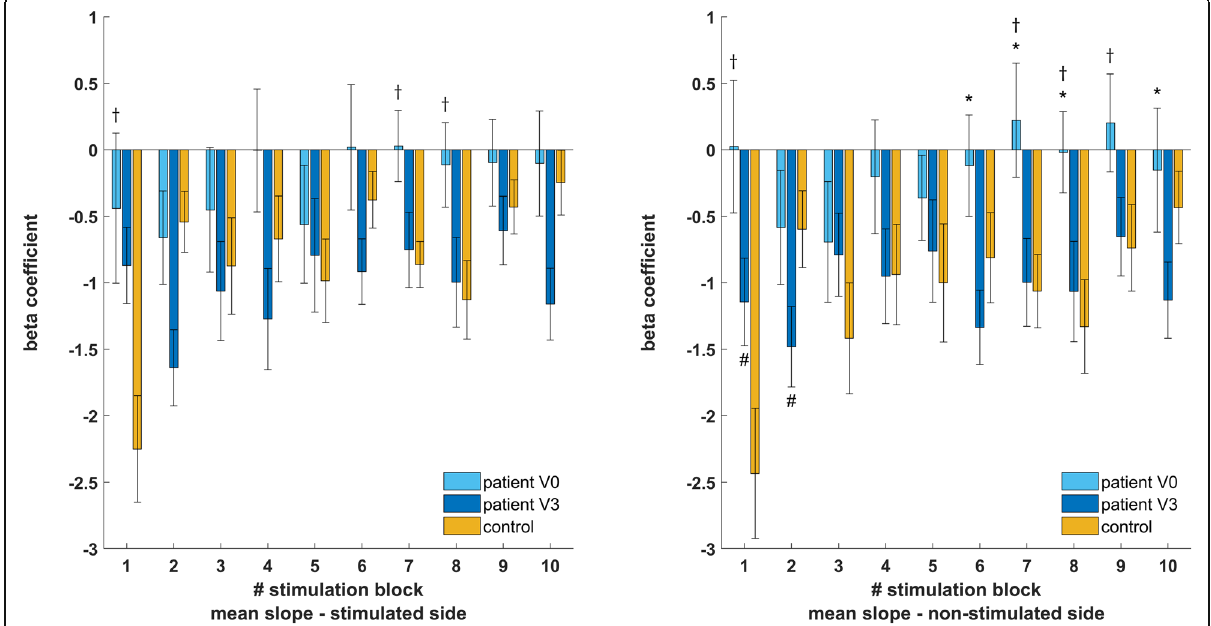
Fig. 3 blockwise comparison of nBR habituation in patients with migraine and controls. R2h is attenuated in migraine and has even a trend towards facilitation in later blocks at V0. After three months of treatment with CGRP mAbs, R2h normalizes and consecutive stimuli are inhibited in all blocks. There remains a significant difference between V3 and controls on the non-stimulated side. * - indicates statistically significant difference between V0 and V3 in migraine. † - indicates statistically significant difference between V0 and controls. # - indicates statistically significant difference between V3 and